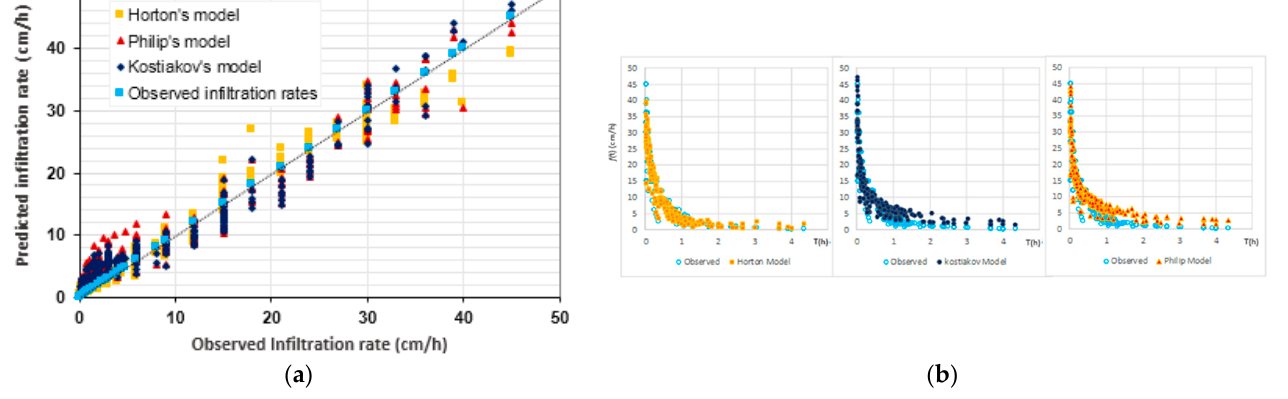
Figure 6. ( a ) Overall linear dependency of observed versus simulated infiltration rates at all site locations. ( b ) Overall behavior of the models’ simulations compared to the overall field measure- ments.